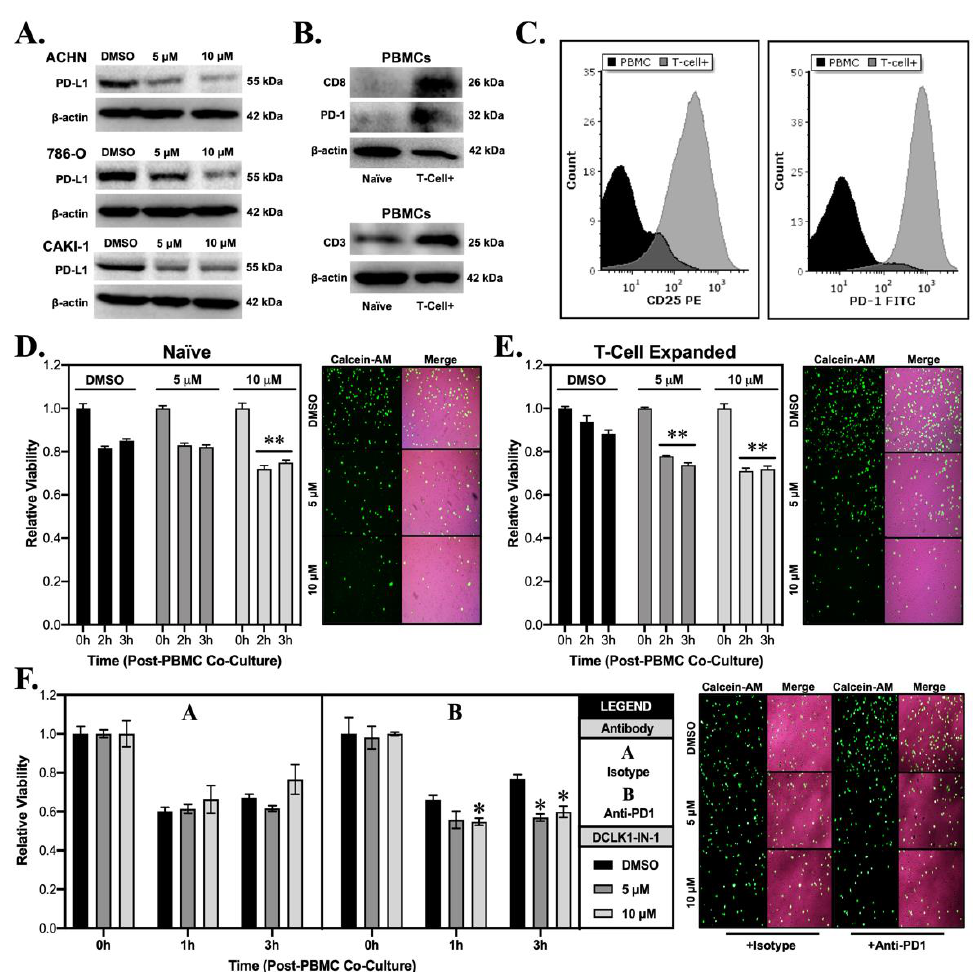
Figure 4. DCLK1-IN-1 downregulates immune checkpoint marker PD-L1 and enhances anti-tumor immunity in co-culture. ( A ) Immunoblotting from ACHN, 786-O, and CAKI-1 cells treated with DMSO or DCLK1-IN-1 demonstrating a dose-dependent decrease in the expression of tumor immune checkpoint ligand PD-L1. ( B ) Immunoblotting of proteins isolated from naïve and T-cell expanded PBMCs confirming increased expression of T-cell markers CD8, PD-1, and CD3. ( C ) Flow cytometry results for PBMCs and T-cell expanded PBMCs confirming successful T-cell expansion via strongly increased expression of membrane CD25 (manufacturer-recommended confirmation marker) and PD-1 (immune checkpoint marker). ( D , E ) 786-O was selected for co-culture assays based on its characteristically strong PD-L1 expression, pre-treated with vehicle (DMSO) or DCLK1-IN-1, counted by trypan blue exclusion, stained with Calcein-AM (green fluorescence), and seeded into co-culture with PBMCs or T-cell expanded PBMCs. Following, 3 h co-culture, 786-O cells demonstrated significant sensitivity to anti-tumor immunity from PBMCs after 10 µ M pre-treatment with DCLK1-IN-1 ( D ) and from T-cell expanded PBMCs after 5 and 10 µ M pre-treatment with DCLK1-IN-1 ( E ) (** p < 0.01 vs. DMSO at corresponding time; representative images included adjacent to graphs and merged with brightfield images; 10 × magnification). ( F ) Co-culture assay of 786-O RCC cells pretreated with vehicle (DMSO) or DCLK1-IN-1 (5 or 10 µ M), and PBMCs pre-treated with isotype antibody or anti-PD1, demonstrating a statistically significant effect on 786-O cell viability at 3 h for DCLK1-IN-1 pre-treated 786-O cells (* p < 0.05 vs. DMSO at corresponding time; 10 × magnification).